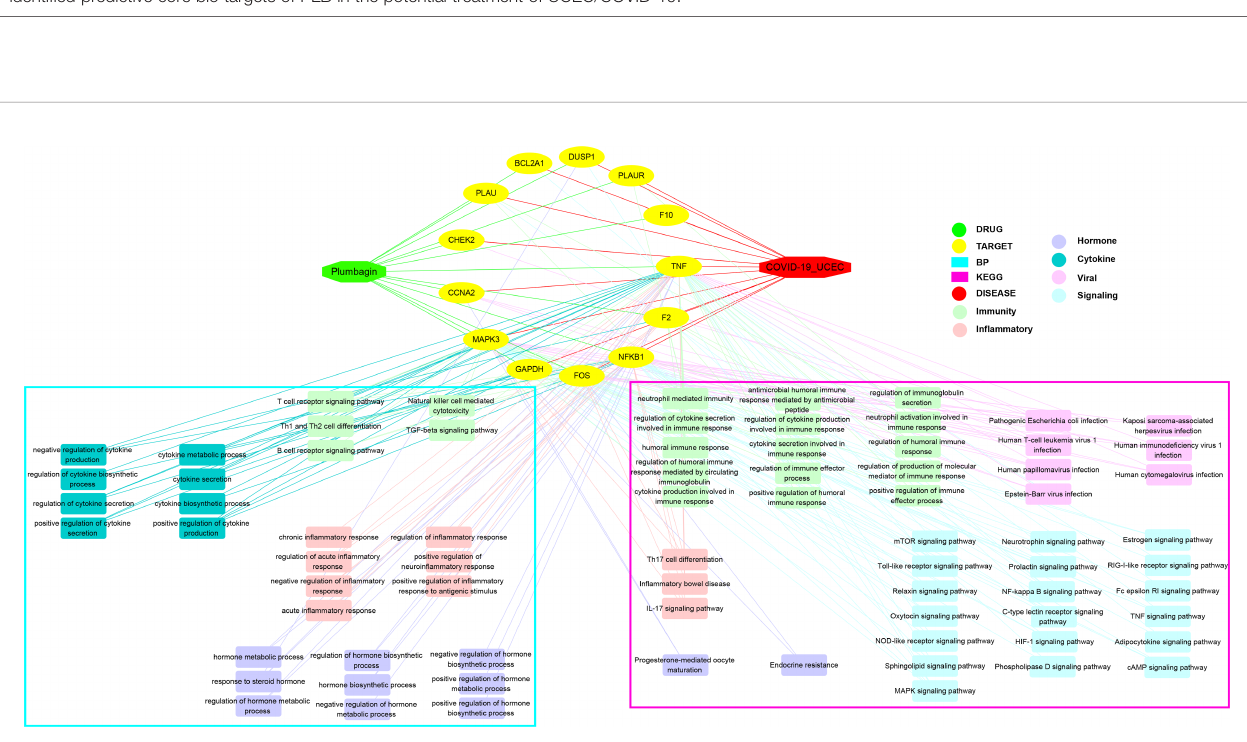
FIGURE 6 | Interaction network connection of candidates, core bio targets, BP, functions, and molecular pathways of PLB in the treatment of UCEC/COVID-19 by using Cytoscape analysis.